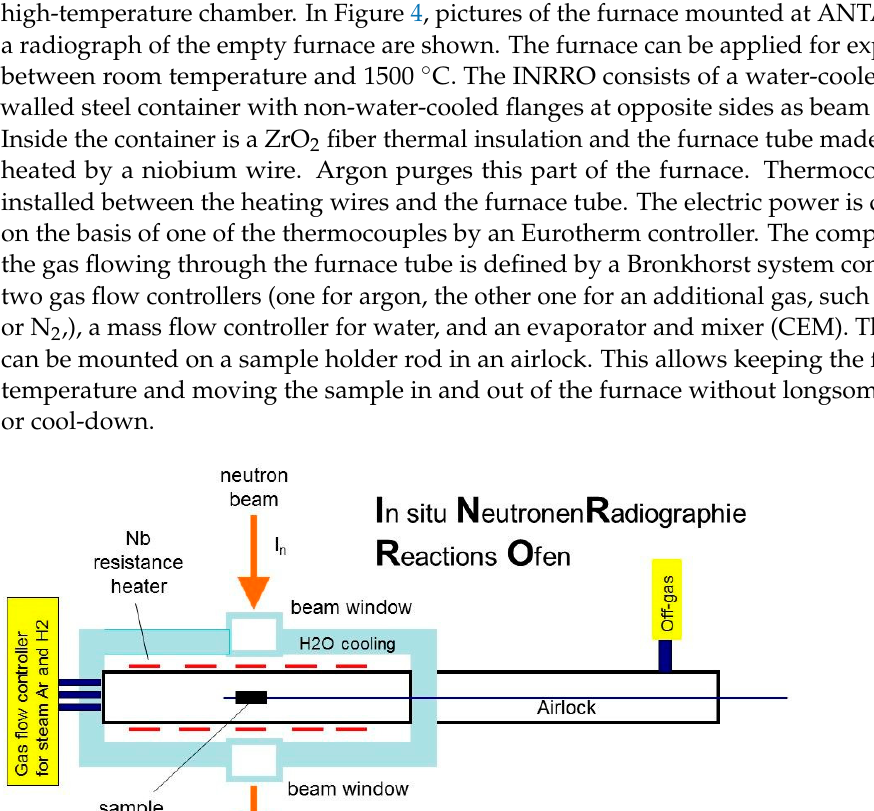
Figure 4. The INRRO furnace mounted at the ICON beamline and a radiograph of the empty fur- nace. Another example is a special sample holder for in situ tensile tests at a defined tem- perature in the range of room temperature to 450 °C to study the hydrogen redistribution in stressed and precracked pressure tube samples constructed by CNEA, Buenos Aires, Argentina (see Figure 5). This sample holder can be mounted at a load machine and heat a sample to the test temperature. The first in situ tests with this sample holder were al- ready performed at ANTARES, FRM II. The data analysis is still in progress, and the re- sults are not yet published. Figure 5. Sample holder constructed by CNEA, Buenos Aires, for a mechanical load machine to perform tensile tests at higher temperatures.